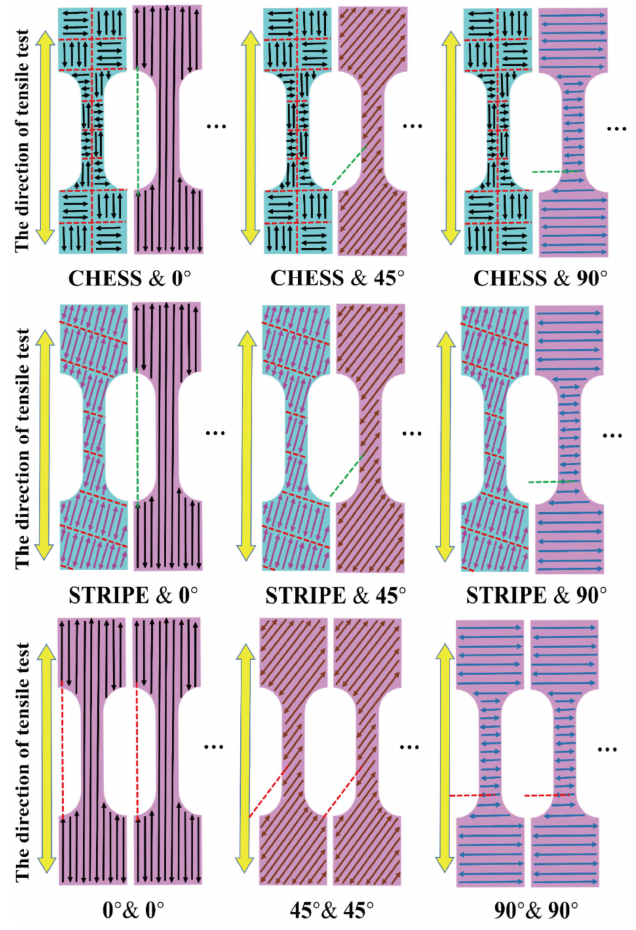
Figure 3. The schematic diagram of the combination of different scanning